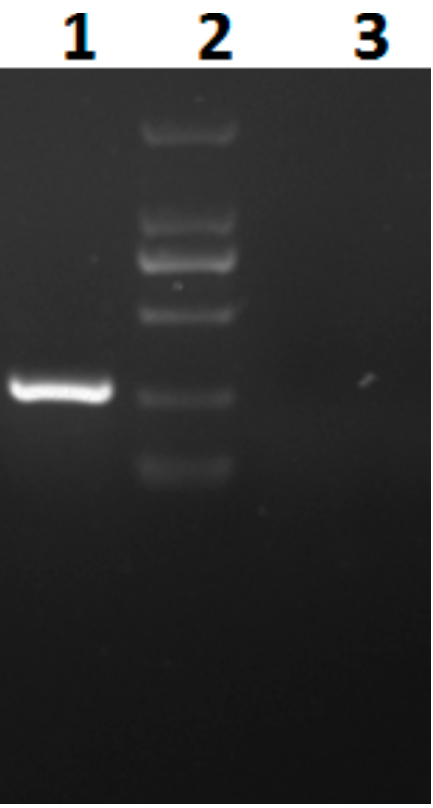
Figure 4. Polymerase chain reaction (PCR) amplification of the total DNA of S. tuberosum using a primer pair specific to CgCV1-dsRNA3-like sequence. From left to right: DNA template extracted from S. tuberosum (lane 1), Marker in size rank of 100 bp, 250 bp, 500 bp, 750 bp, 1000 bp, 2000 bp (lane 2), DNA template extracted from control plant (lane